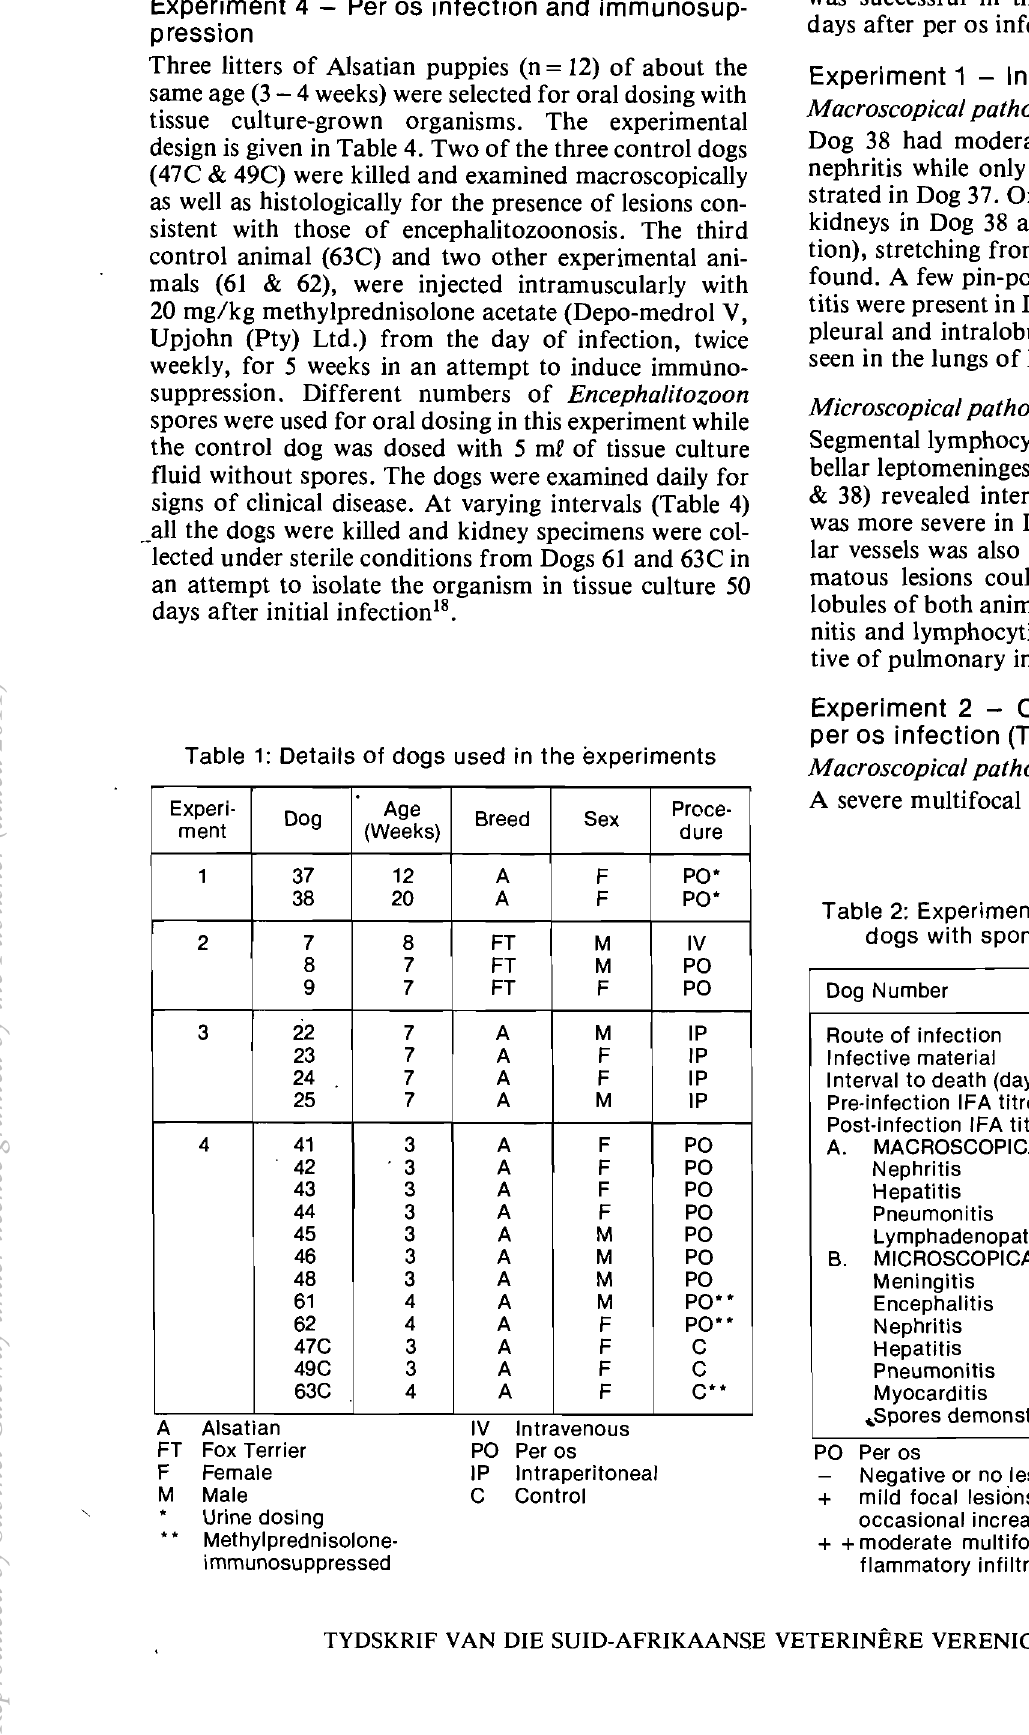
Table 2: Experiment 1 - Oral dosing with urine from dogs with spontaneous encephalitozoonosis Dog